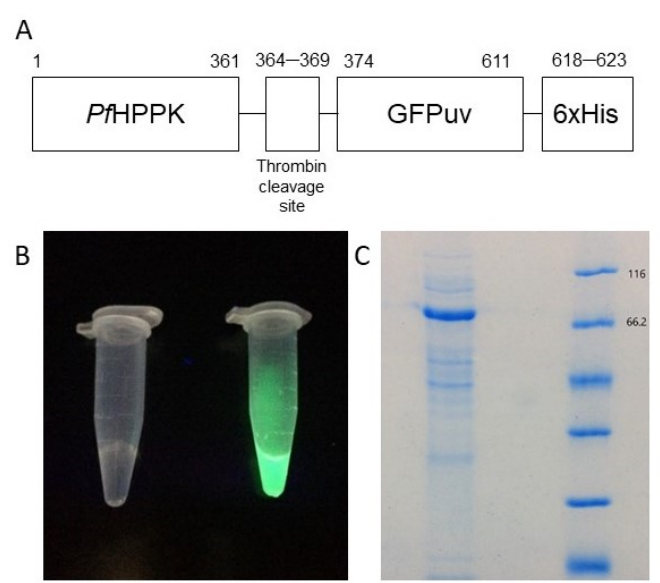
Figure 2. Cloning, expression and purification of Pf HPPK-GFP. ( A ) Schematic sequence of Pf HPPK- GFP. ( B ) UV-light exposed samples of buffer ( left ) and Pf HPPK-GFP ( right ). ( C ) SDS-PAGE of purified Pf HPPK-GFP.